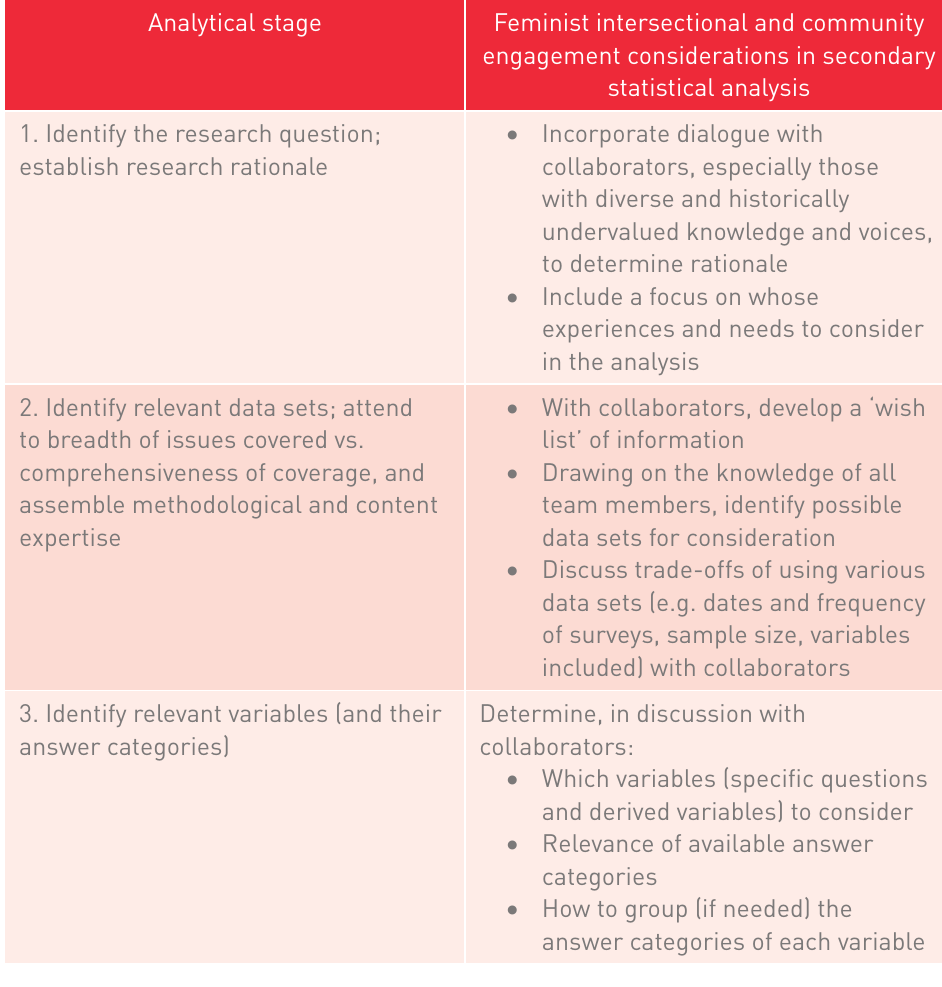
Feminist intersectional community-engaged statistical analyses Analytical stage